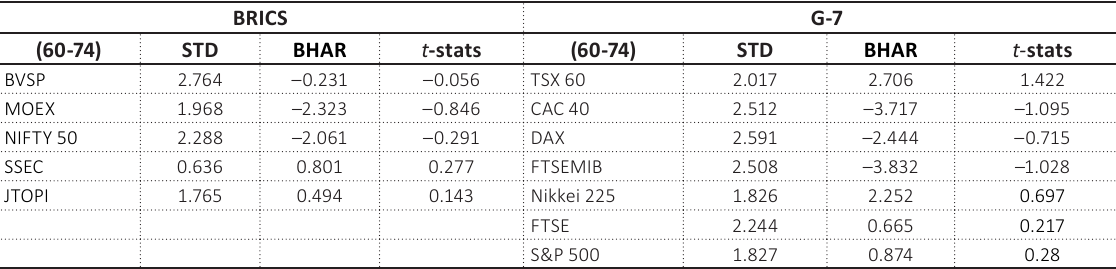
Table 7. BHAR in the event window (60-74) for G-7 and BRICS